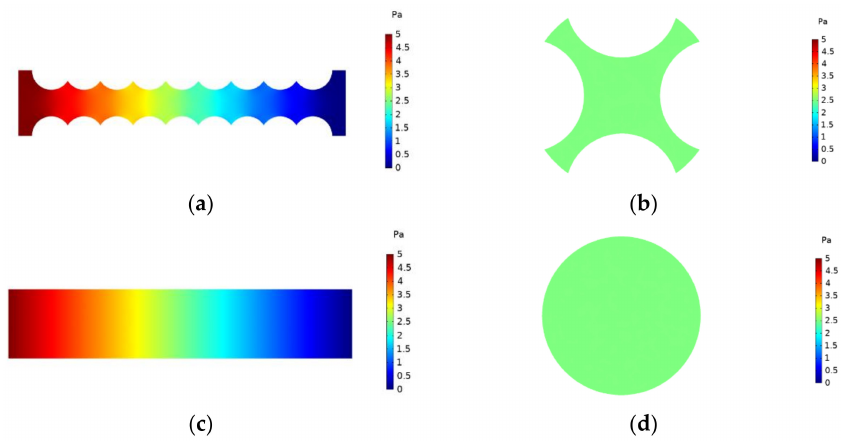
Figure 10. Pressure field distribution. ( a ) Profile of pressure (xy) in rough wall model; ( b ) profile of pressure (xz) in rough wall model; ( c ) profile of pressure (xy) in smooth wall model; ( d ) profile of pressure (xz) in smooth wall model.